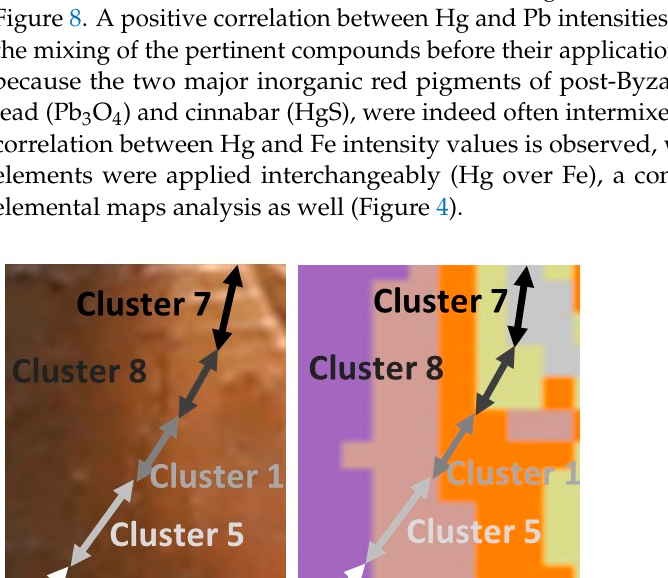
Figure 8. Intensities of Fe K α , Cu K α , Au L α , Hg L α and Pb L α transitions for each cluster, extracted with the method of ROI from the representative spectra. Left : Intensities of specific transitions (that pertain to a specific element) for the various clusters. As an example, the maximum intensity of the Fe K α is about 175 counts, and it is observed in Cluster 5, while the maximum intensity of the Cu K α (~1300 counts) is in Cluster 2. The average transition intensities per pixel are marked by red crosses. Right : Transition intensities per specific cluster. For instance, in Cluster 2 the maximum intensity corresponds to the Cu K α , followed by the Pb La.